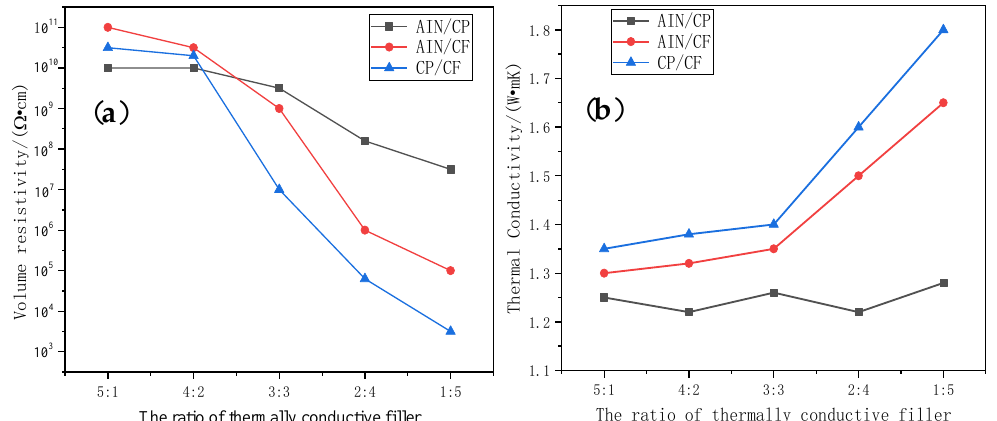
Figure 7. Volume resistivity and thermal conductivity of TSGs with different compositions. ( a ) Volume resistivity. ( b ) Thermal conductivity.